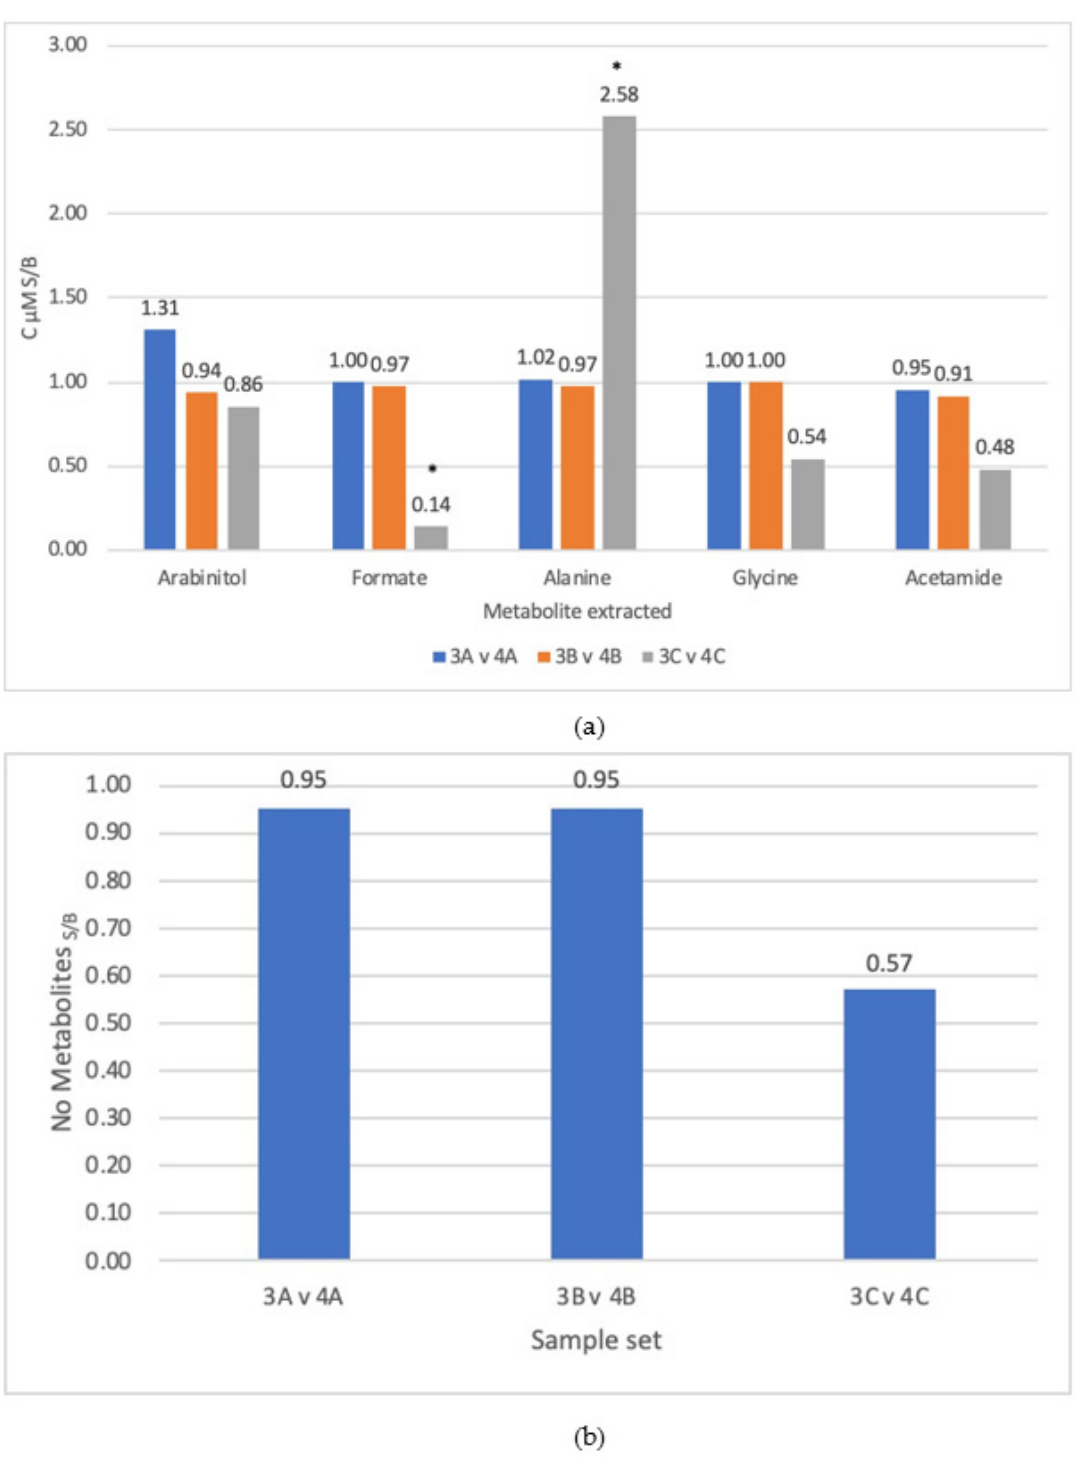
Figure 2. ( a ) Difference in concentrations between sonication (3) and bead bashing (4) C µ MS/B lysis techniques for the triplicates A–C. ( b ) Difference in the number of different metabolites extracted between sonication (3) and bead bashing (4) lysis techniques NS/B for triplicates. Numbers below 1 indicate an increased extraction for bead bashing. * = outliers, numbers above the bars indicate measured